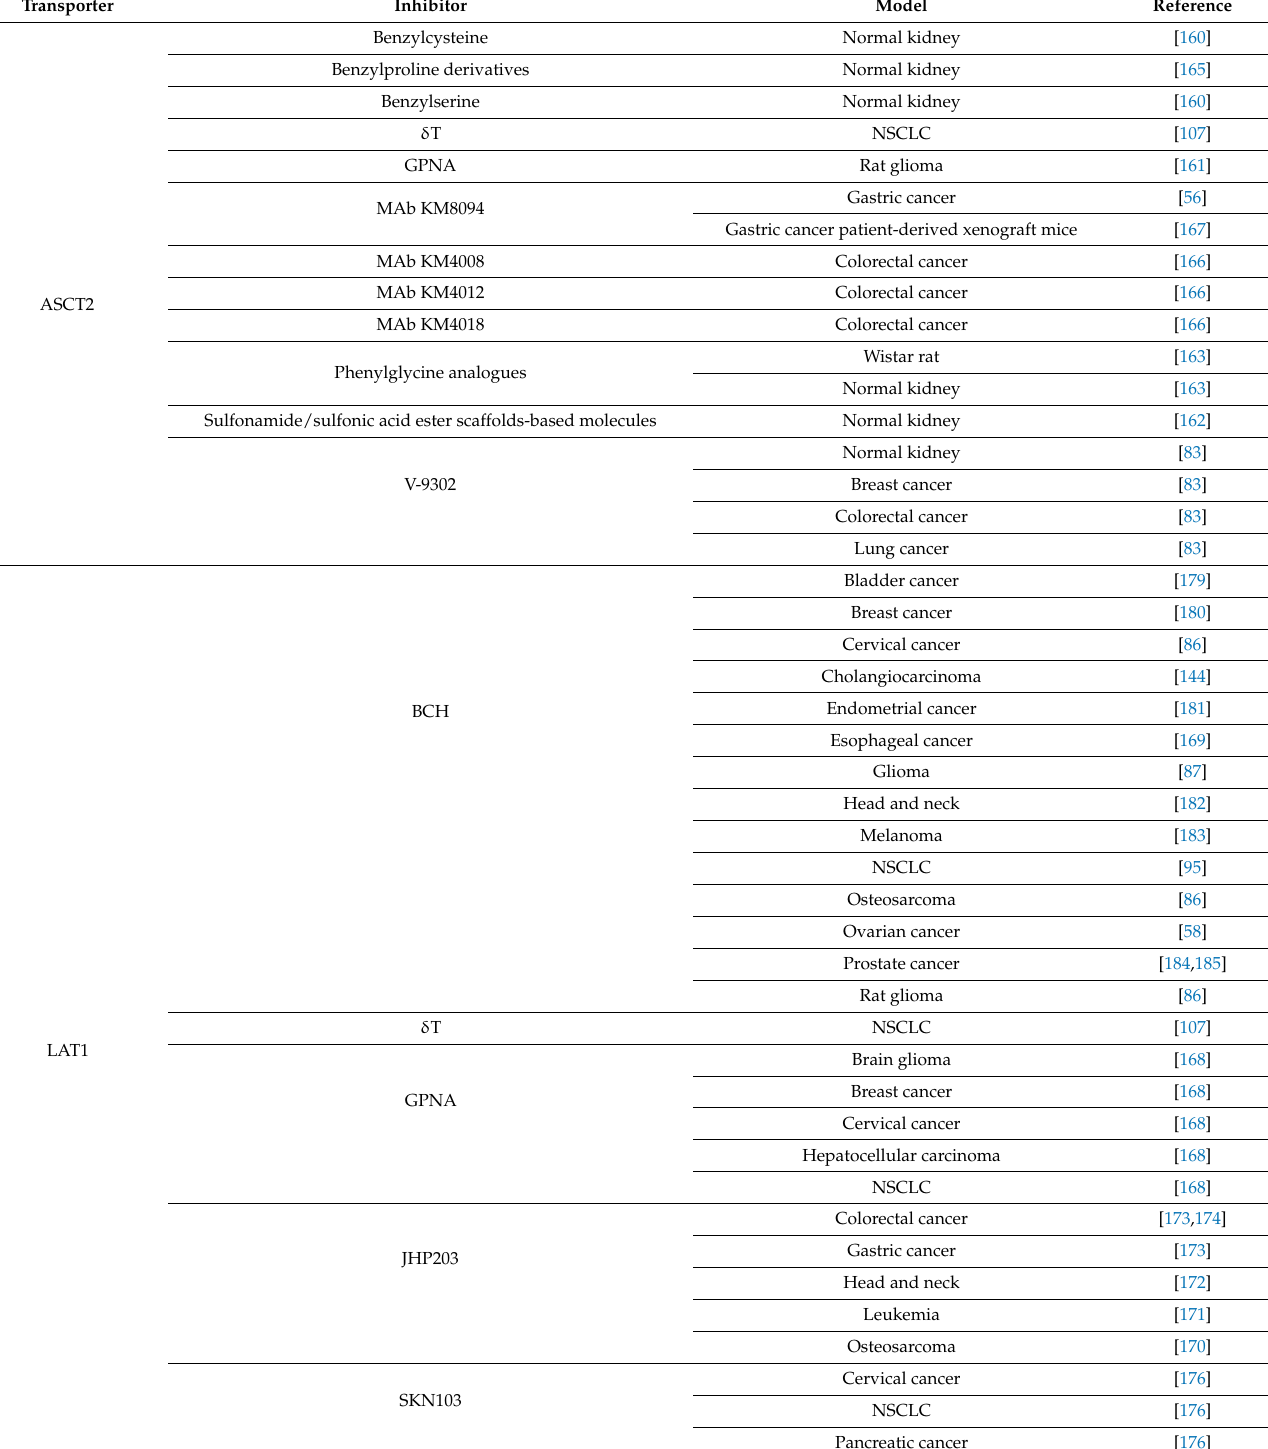
Table 2. ASCT2 and LAT1 pharmacological